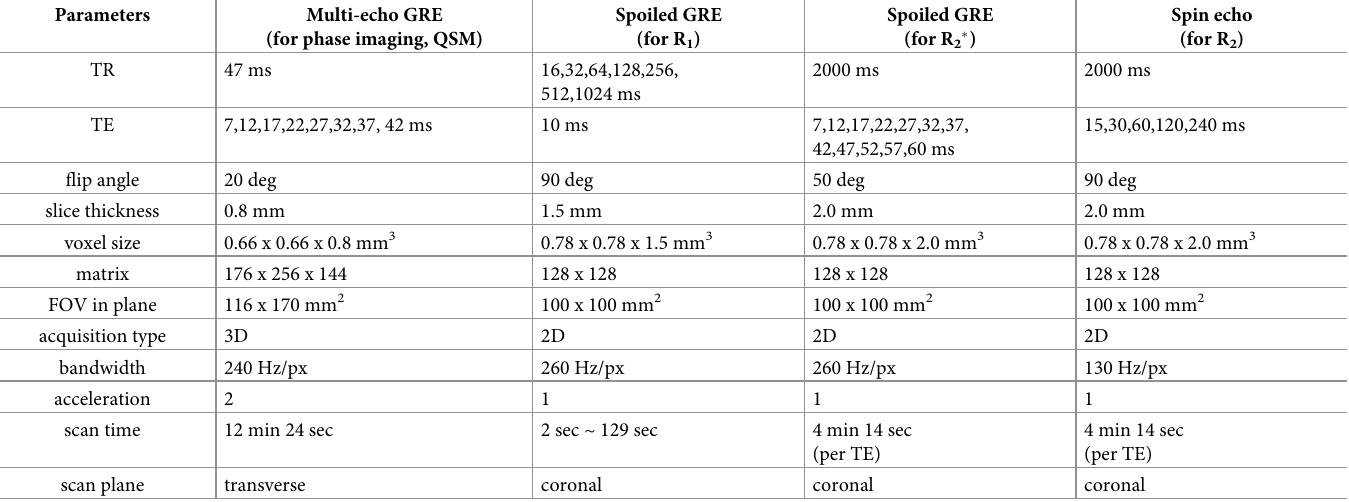
Table 2. Scan parameters for volumetric phase imaging and single-plane relaxation parameter mapping.